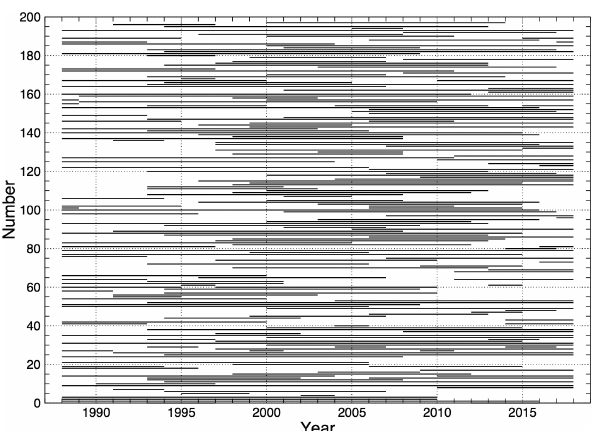
Figure 12. Surge periods for all glaciers with observed surges (GI- 3min). Those starting (ending) in 1988 (2018) might have started earlier/lasted longer than indicated by the